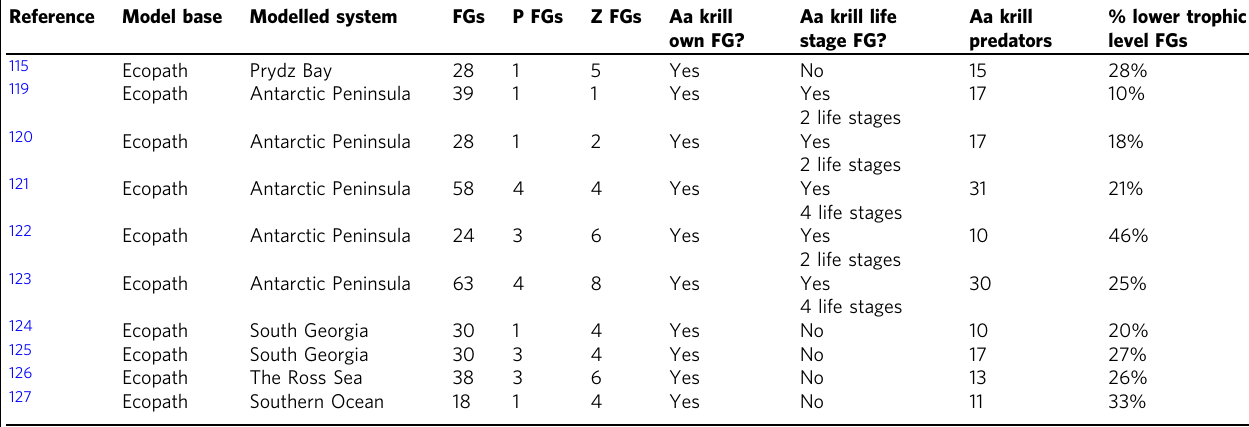
Table 1 Summary of lower trophic level representation (krill, zooplankton and below) in Southern Ocean foodweb models Reference Model